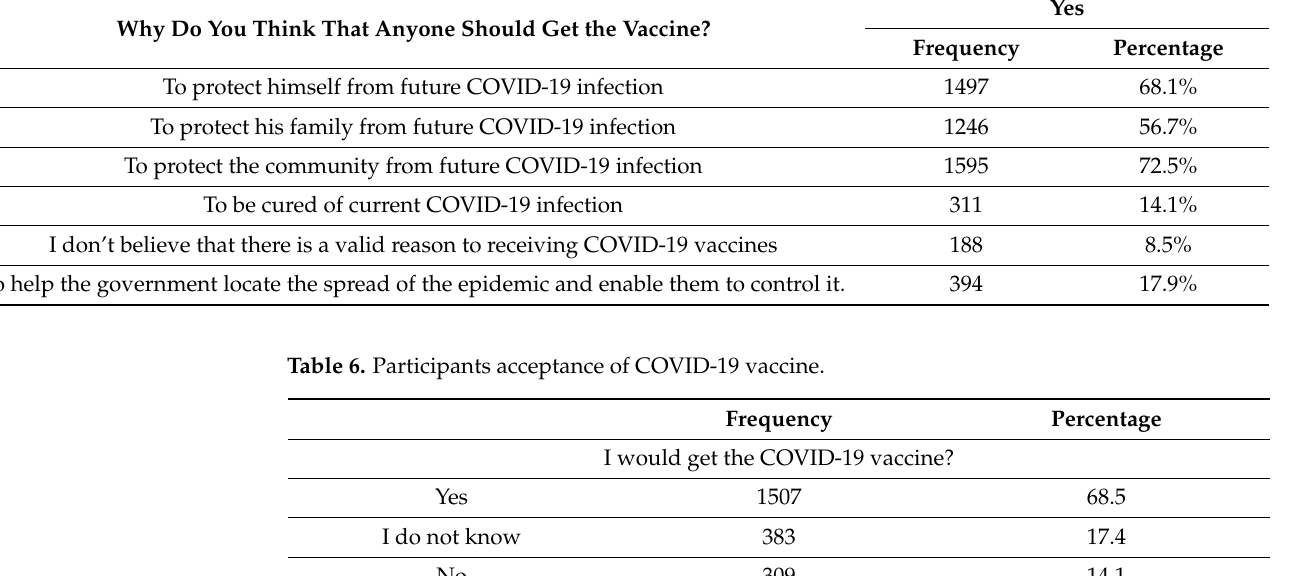
Table 5. The participants’ motives behind receiving the vaccine.